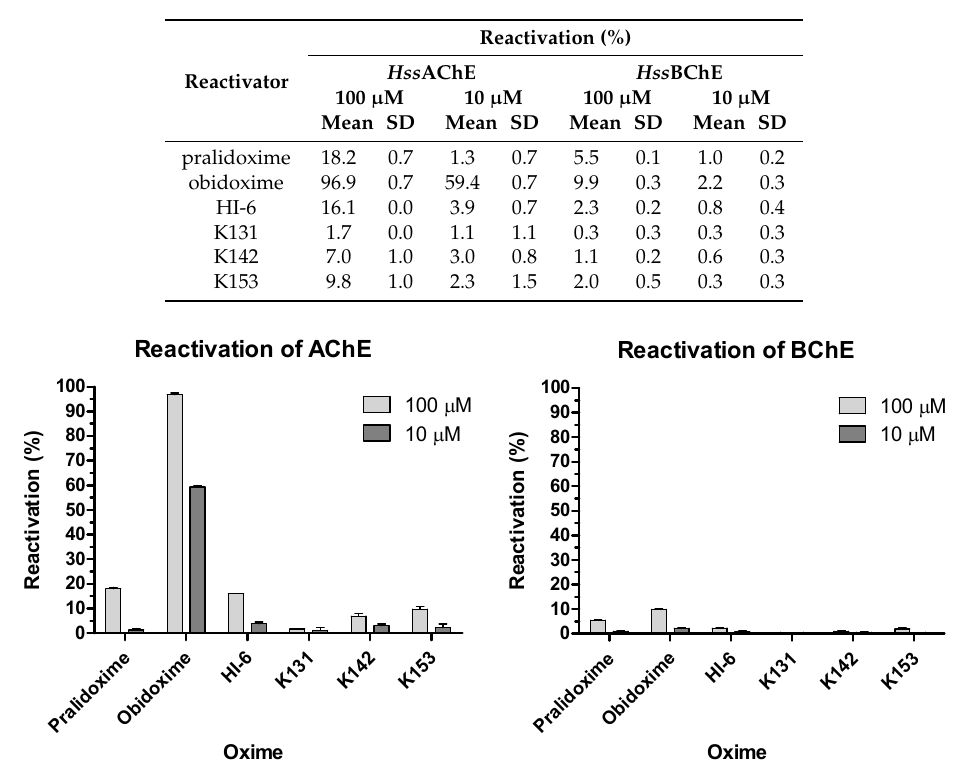
Table 1. Potency of tested oximes to reactivate POX-inhibited erythrocyte Hss AChE and plasma Hss BChE at concentrations 100 µM and 10 µM. (%, mean value of three independent determinations;